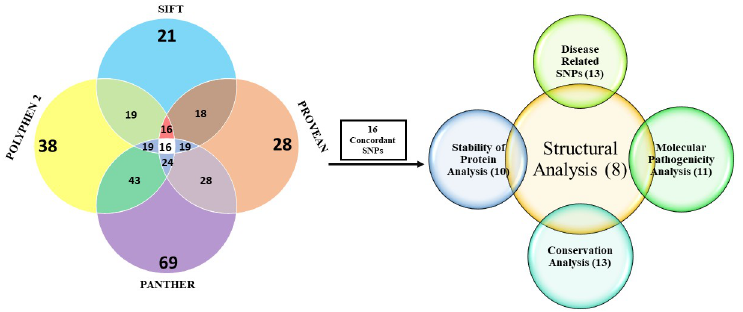
Fig 2. Venn diagram representation of most deleterious nsSNPs estimated by various in silico tools. A total of 16 SNPs were showed concordant results as deleterious nsSNPs by SIFT, PolyPhen 2.0, PROVEAN and PANTHER. Further analysis of these SNPs using different in silico tools resulted in 8 nsSNPs, which were selected for structural analysis.